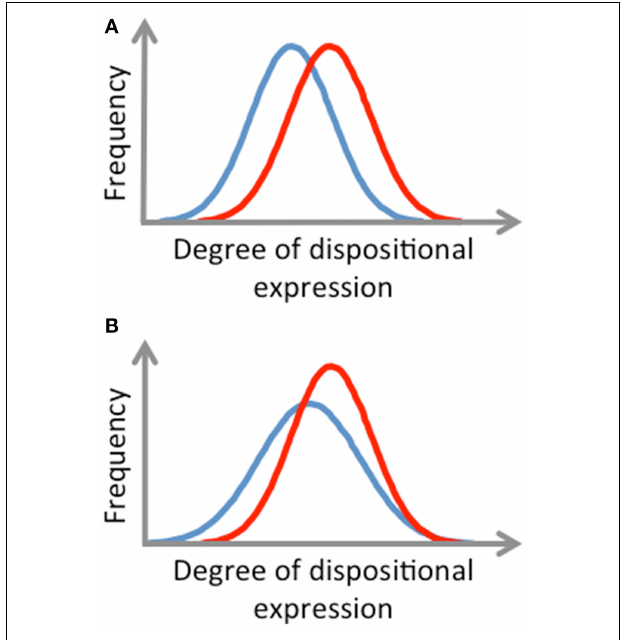
FIGURE 2 | Illustrative frequency distributions of momentary, cross-situational dispositional expressions displaying differences in degree of virtue possession. (A) The red curve displays a distribution representing a higher typical degree of virtue expression (higher mean score) than the blue curve. (B) The red curve represents a higher typical degree of (higher mean score), and more consistent (less variable), virtue expression than the blue